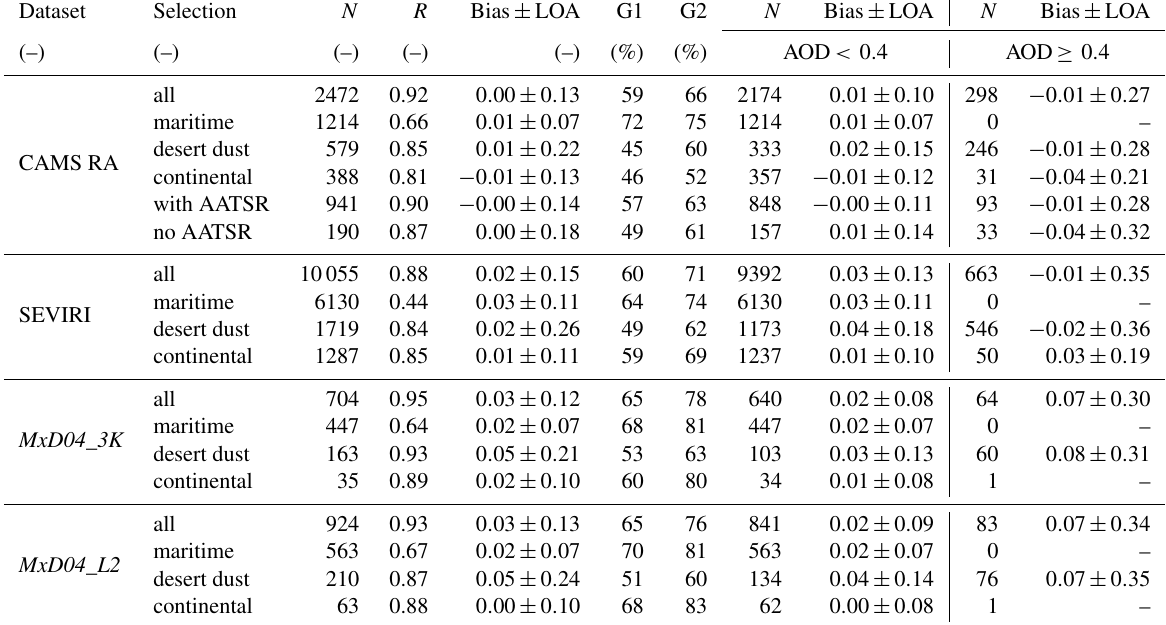
Table 5. Statistics comparing MIC reference AOD at 550nm versus CAMS, SEVIRI and MxD04 aerosol products. The comparison is shown for the collocated datasets with different selections based on aerosol type (maritime, desert dust, and continental) and for CAMS RA with and without available AATSR measurements. Further, the comparisons are separated based on the MIC AOD for all AOD values, as well as AOD higher and AOD lower than 0.4. N denotes the number of collocated data points for all selections. Also listed are the correlation ( R ) and the bias fraction of data based on the limit of agreement (LOA) method for the 95% confidence interval. G1 and G2 indicate the percentage of data points lying within the expected error limits (EE1 and